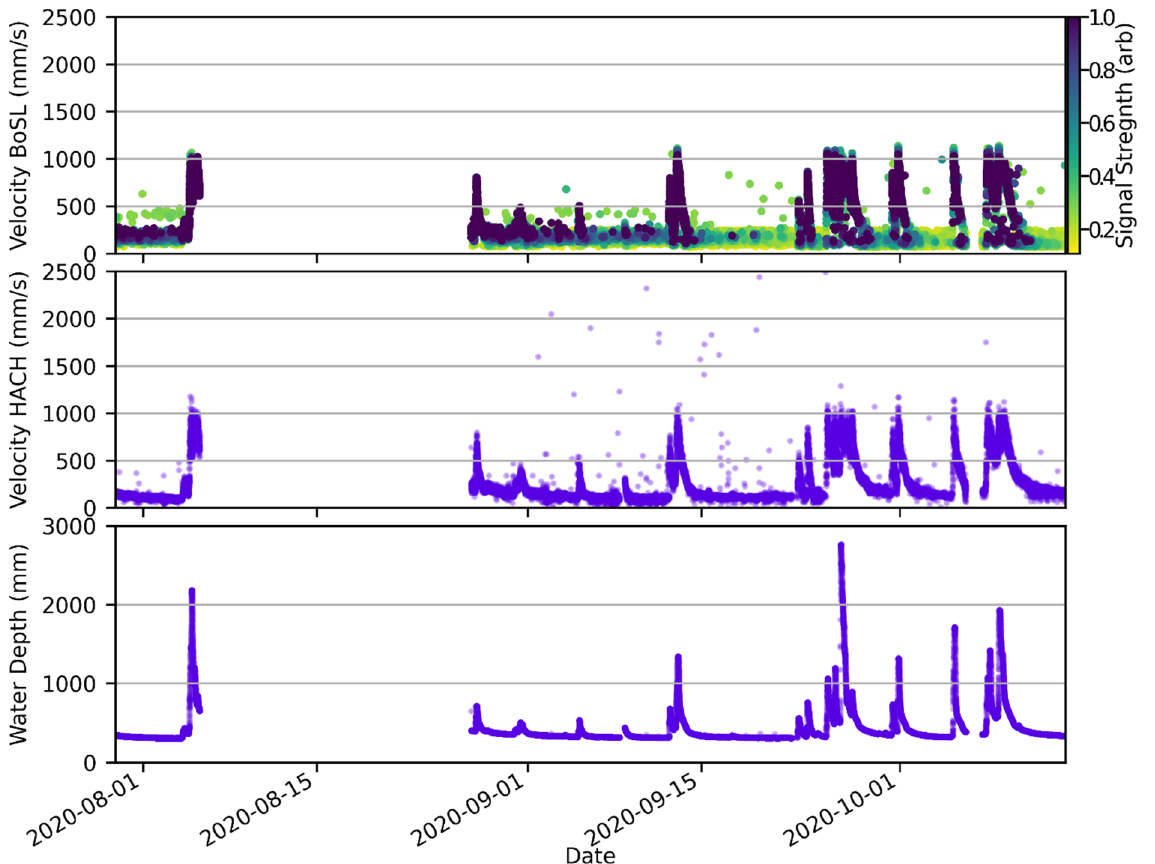
Figure 9. Top: Plot of the velocity measurement of the sensor over time. Middle: HACH probe velocity measurements over time. Bottom: HACH probe depth measurements over time. The x-axis on all plot is the same. There was a pause in data collection from 2020 AUG 5 to 2020 AUG 27. A few data points are beyond the plot range; the full data extends to 3000 mm/s on the y-axis.